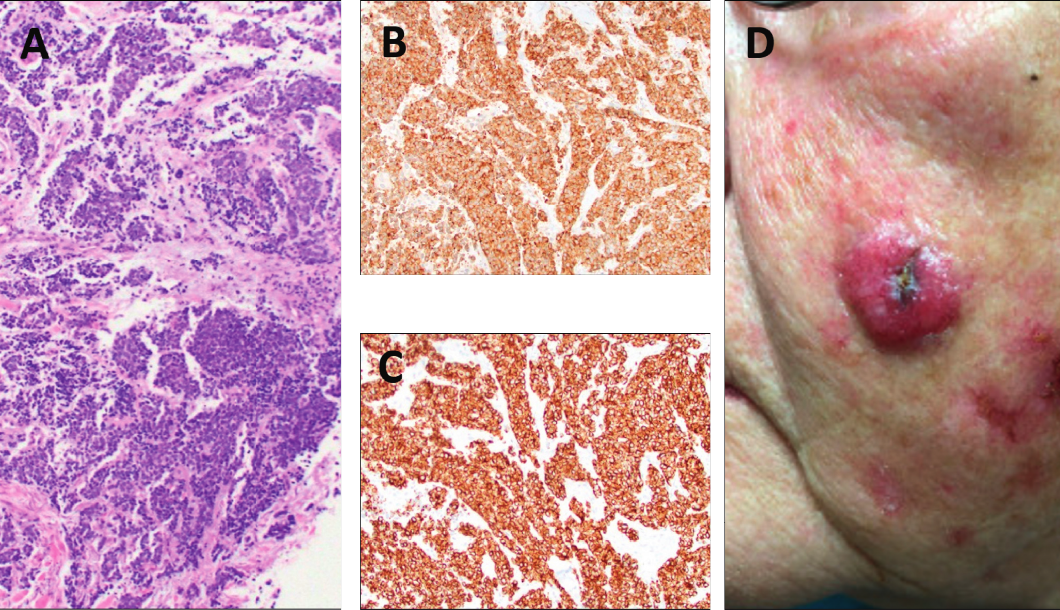
Figure 2: Shave biopsy pathology from the left cheek primary lesion. (a) Small purple cells consistent with neuroendocrine carcinoma. (b) Positivity for synaptophysin. (c) Perinuclear dot-like positivity for cytokeratin 20. (d) Primary lesion two weeks after initial confirmatory